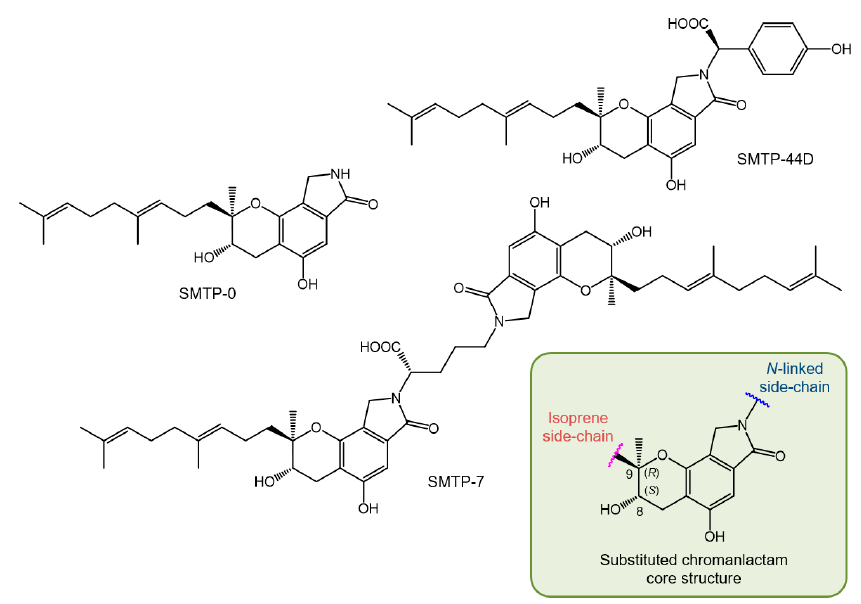
Figure 1. Structures of key Stachybotrys microspora triprenyl phenol (SMTP) congeners and substituted chromanlactam core unit.